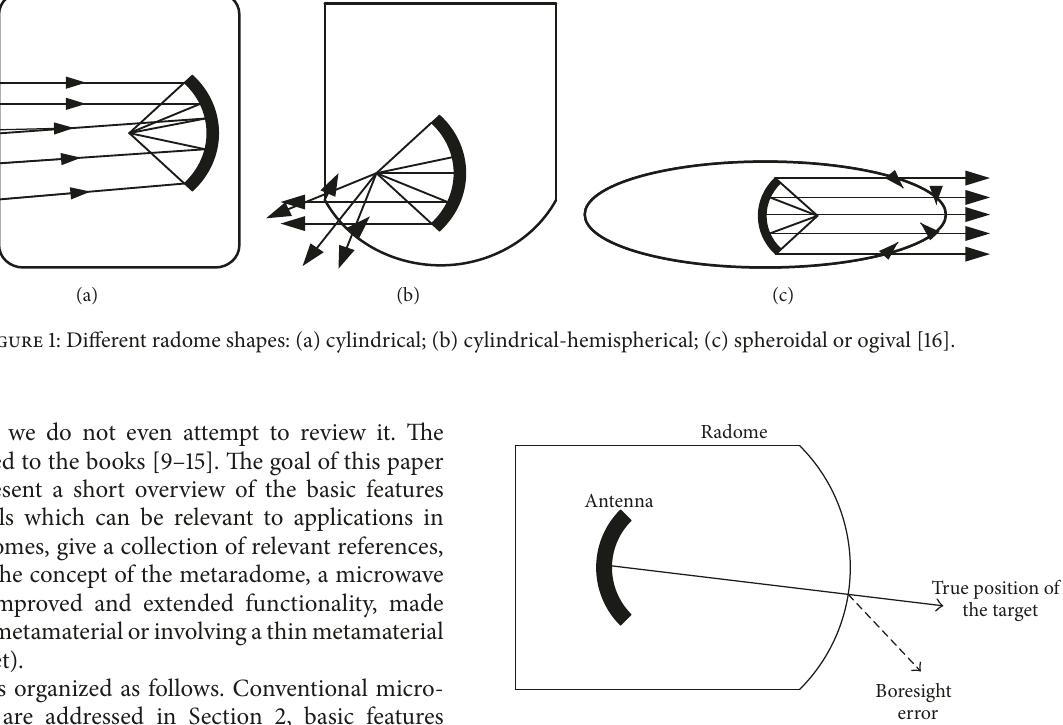
Figure 2: Boresight error in a radome: angular displacement from correct position